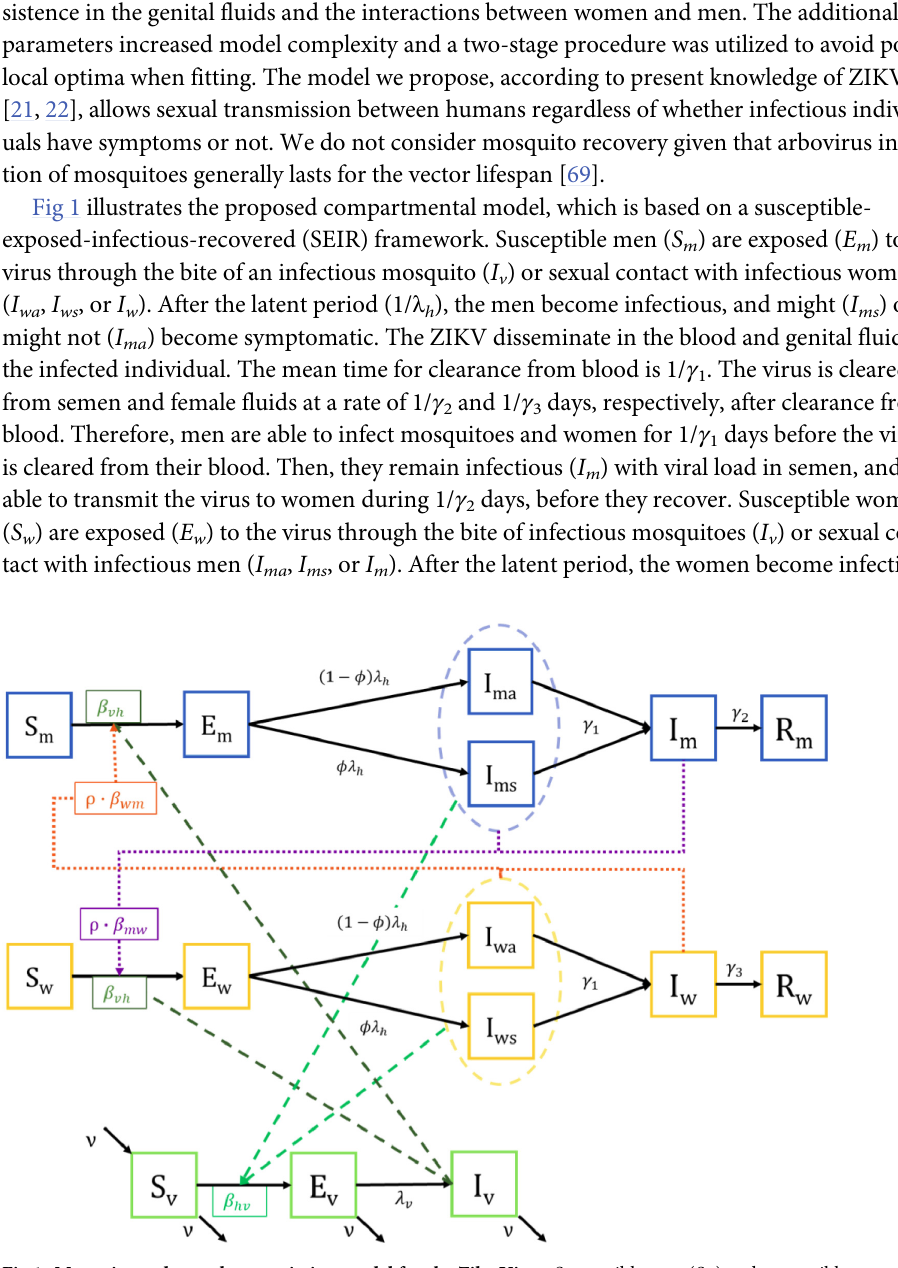
) and susceptible women m